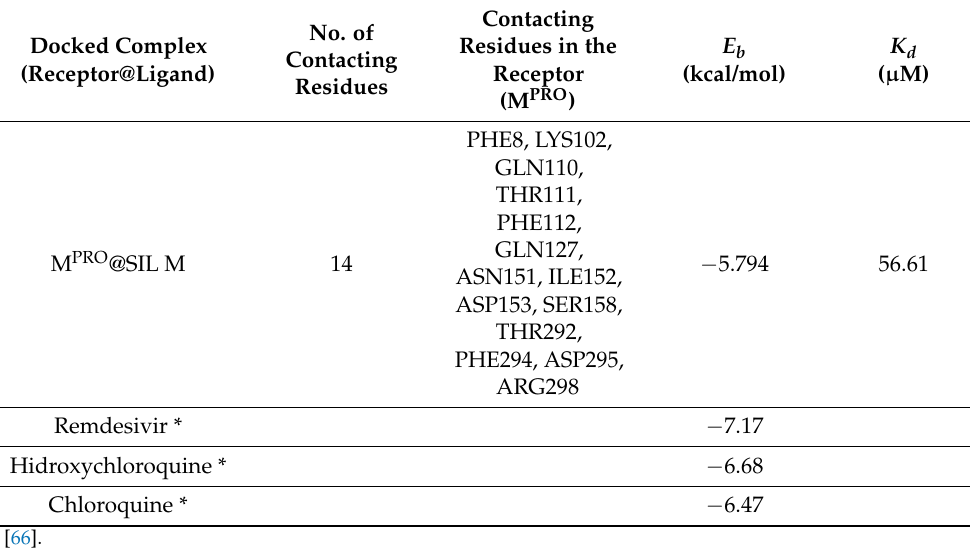
Figure S2: 1 H NMR spectrum of SIL-BS; Figure S3: 13 C NMR spectrum of SIL BS; Figure S4: H, H COSY NMR spectrum of SIL-BS; Figure S5: HSQC NMR spectrum of SIL BS; Figure S6: HMBC NMR spectrum of SIL-BS; Figure S7: UV-vis spectra of the SIL-BS compound in solvents with different polarities showing the keto-enol tautomerism; Figure S8: UV-vis spectra of SIL-BS in PBS (1% DMSO) at pH 1.5, 2.6, 5 si 7.4 during 7 days; Figure S9: 1 HNMR spectra of the SIL-BS at pH 1–4; Figure S10: Cell viability of SIL M and SIL-BS on NHDF cell lines in comparison with cisplatin; Figure S11: 1 HNMR spectra of the SIL-BS before, after the addition of protein (BSA) and after 5 days of incubation of the mixture; Figure S12: H, H COSY NMR spectrum of SIL-BS/protein mixture; Table S1: Bond distances (Å) and angles ( ◦ ) for SIL-BS. The cif and check cif for the compound that is the object of the study were also